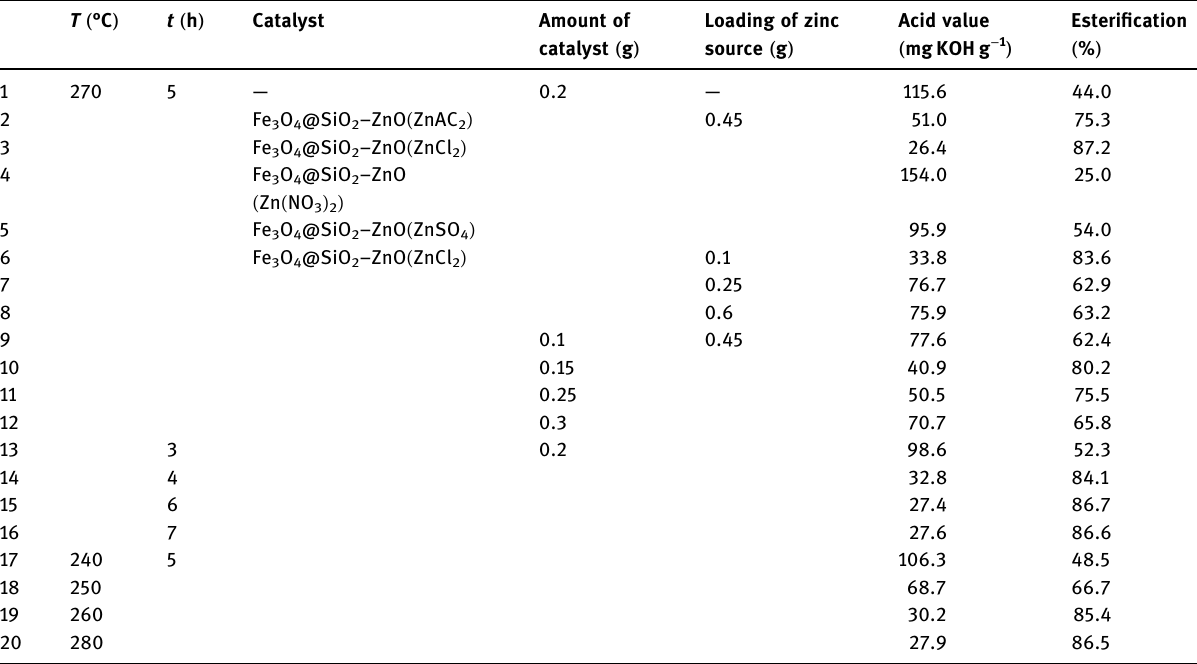
Table 5: Process conditions of rosin glycol ester T ( °C